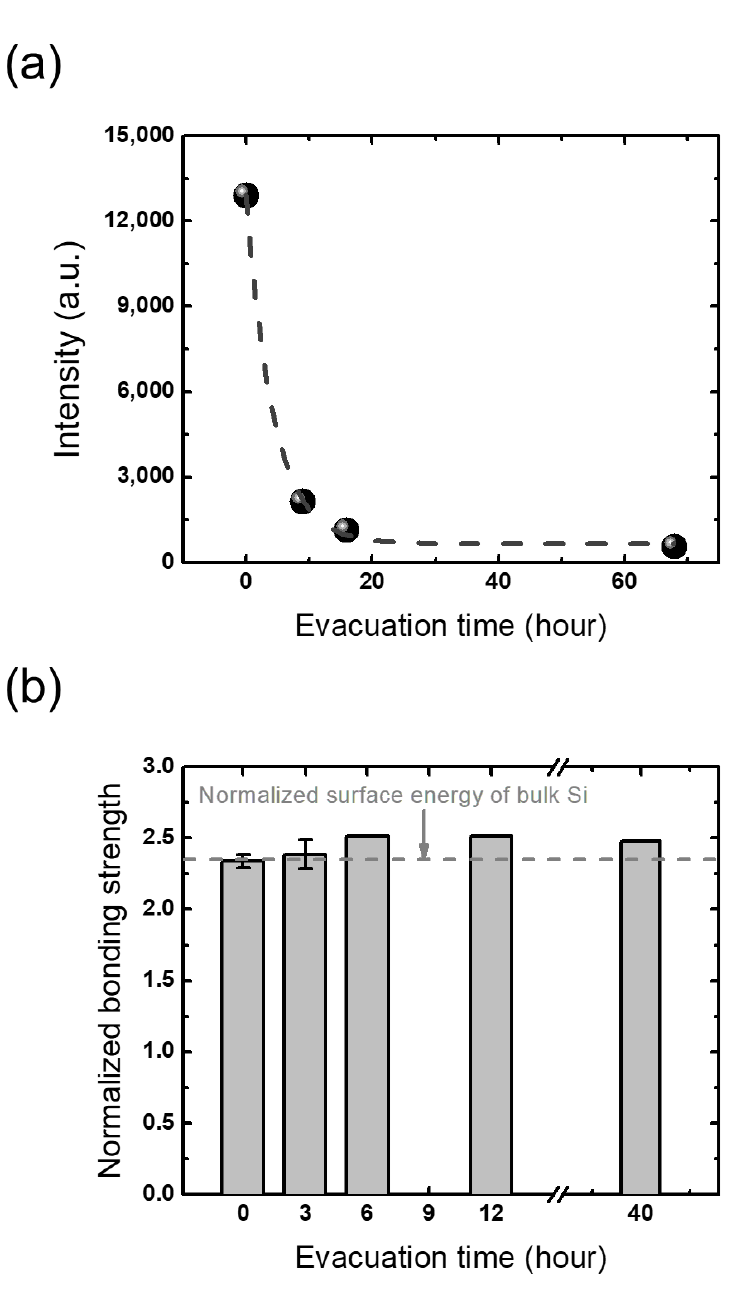
Figure 5. ( a ) Emission intensity of 309 nm wavelength detected by OES as a function of the evacuation time, and ( b ) bonding strengths as a function of the evacuation time normalized to the bonding strength with no plasma treatment.